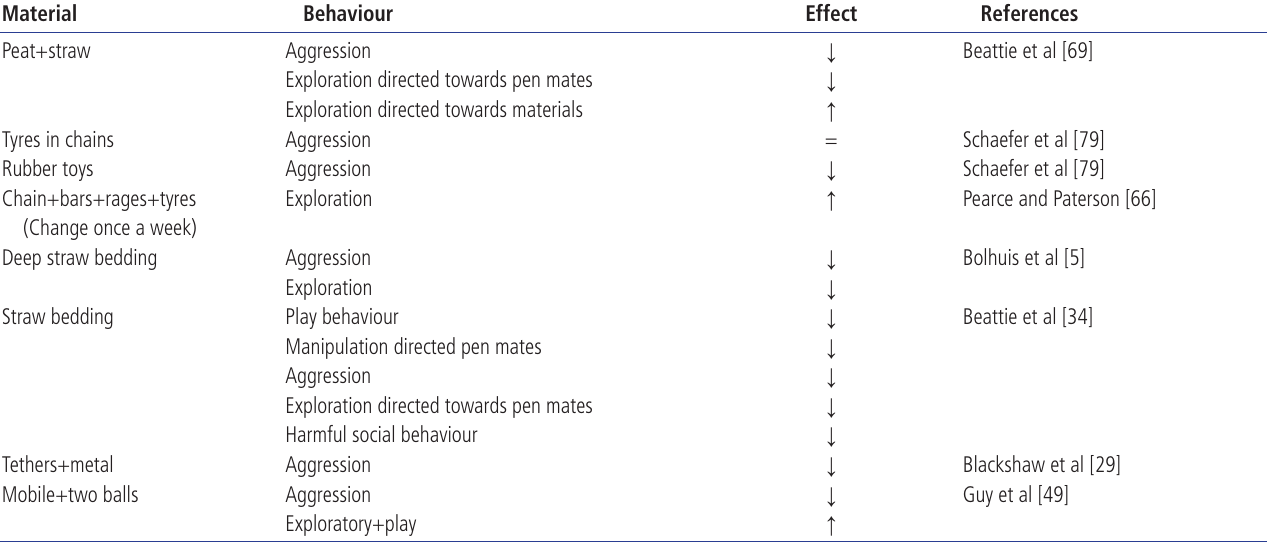
Source, [2]. In the column at left the enrichment materials are listed, in the second column the behaviour is listed in the following order; behaviour redirected towards pen mates, aggression, harmful social behaviours e.g. tail biting, behaviour redirected towards materials or substrate, play behaviour. In the effect column, arrows indicate if the relevant behaviour has been increased or reduced, while equal signs indicate if the behaviour was unaffected. If the desired effects have been achieved arrows are pointing down- wards, while if the desired effects have not been achieved the arrows are pointing